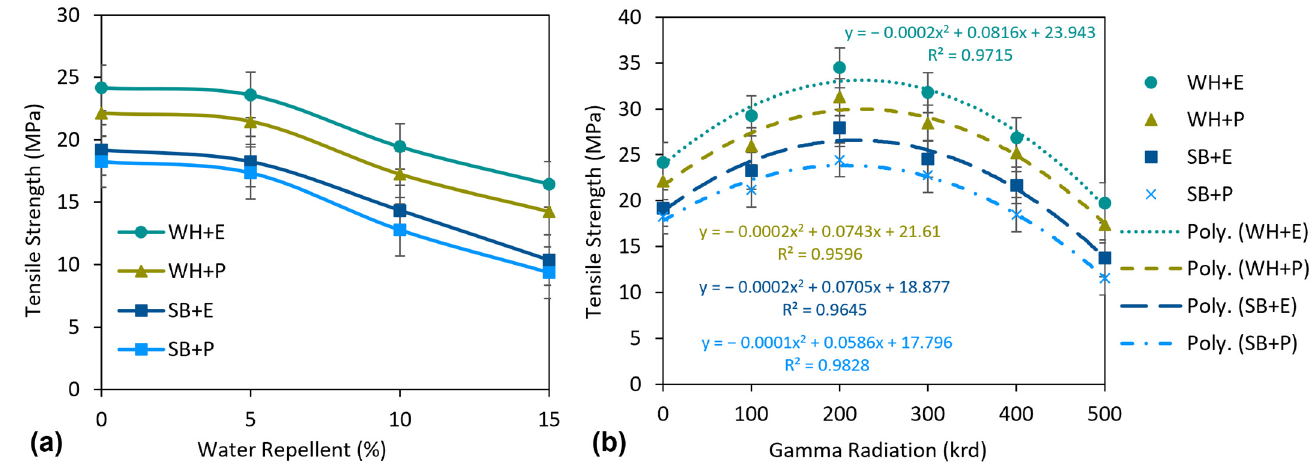
Figure 9. ( a ) Effect of water-repellent treatment and ( b ) effect of gamma radiation on tensile strength of the composites. of the